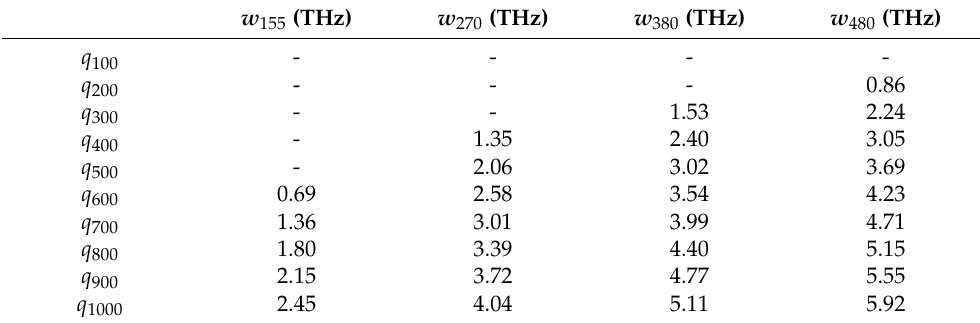
Table 6. Maximum of the plasmon peak for selected momenta at ν = 4.0 × 10 13 s − 1 .